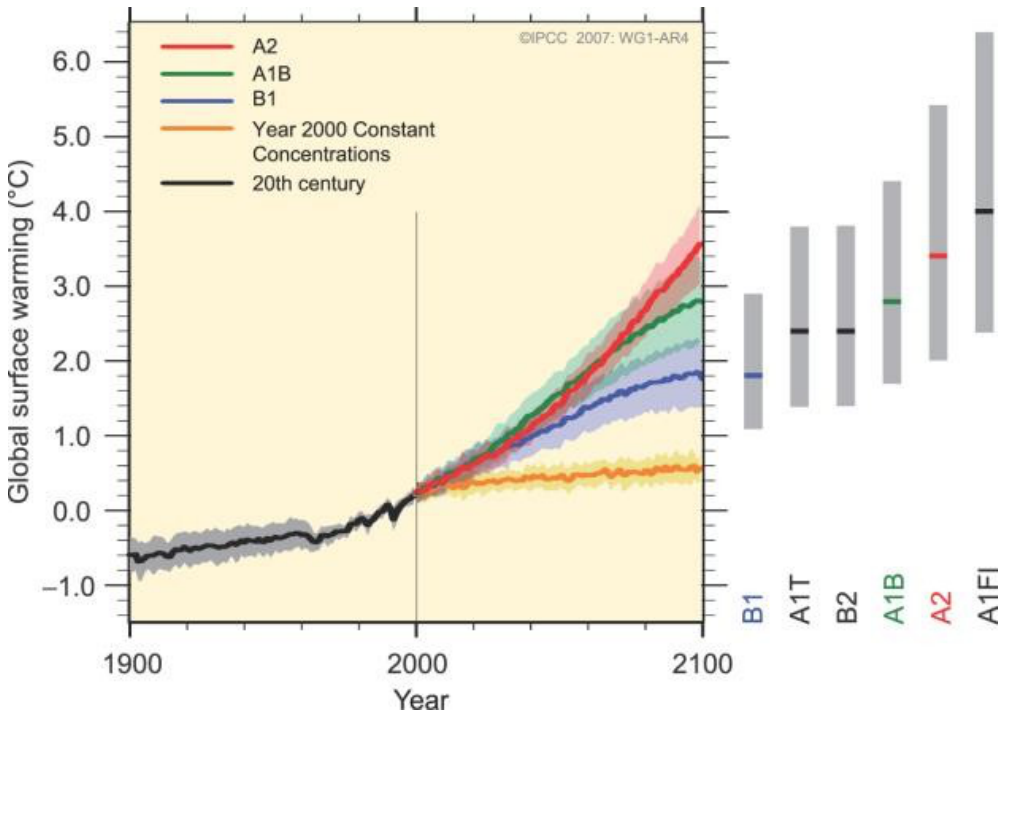
Figure 1. Solid lines are global averages of surface warming (relative to 1980–1999) for four climate change models, shown as continuations of the 20th century simulations. Shading denotes the ±1 standard deviation range of individual model annual averages. The orange line is for an experiment where concentrations were held constant at year 2000 values, the other lines show increases in greenhouse gas concentrations relative to 2000 values. The grey bars at right indicate the best estimate (solid line within each bar) and the likely range assessed for six modeled scenarios. Figure from the Fourth Assessment Report of the Intergovernmental Panel on Climate Change